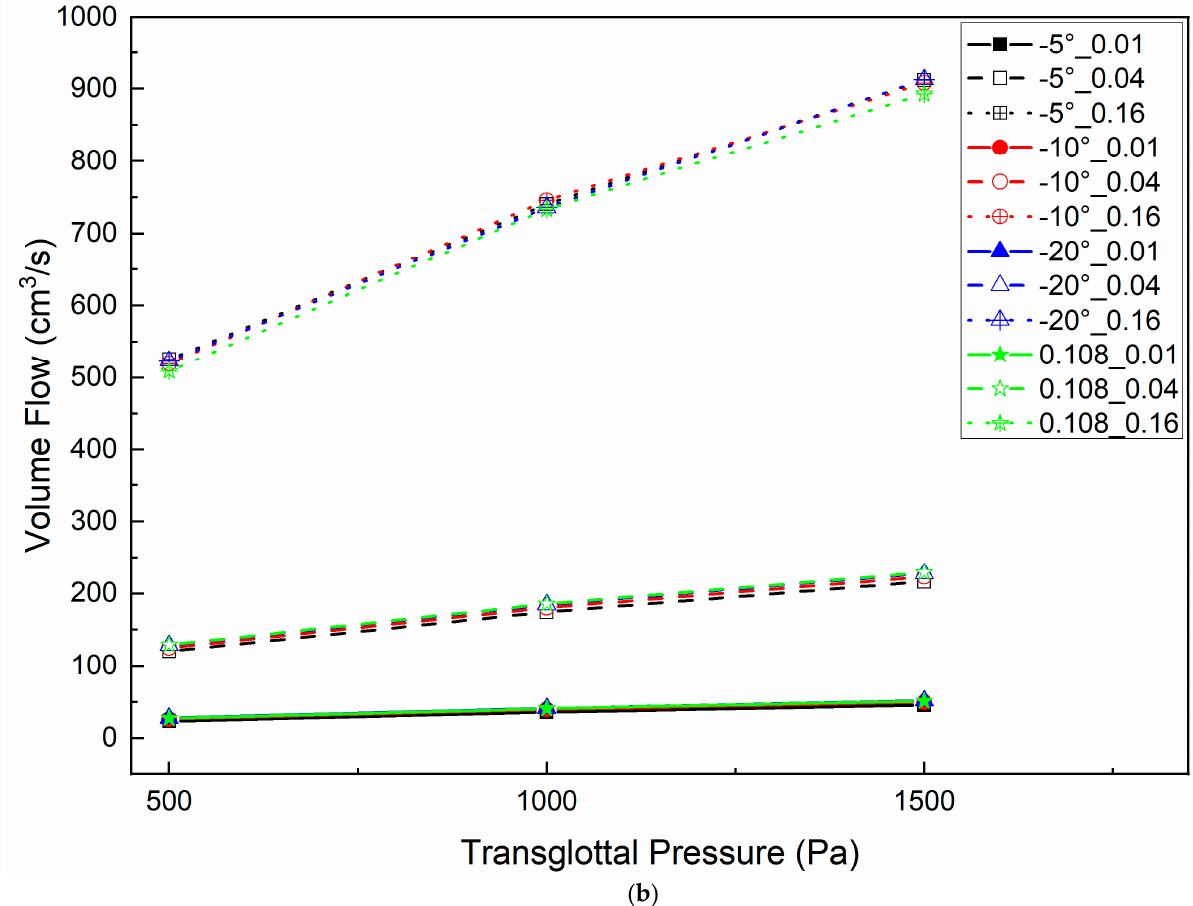
Figure 6. (Color online) Glottal flow distributions for − 5°, − 10°, and − 20° convergent glottal angles and 0.01 cm, 0.04 cm, and 0.16 cm glottal minimal diameters ( a ) for 500 Pa transglottal pressure only; ( b ) for 500 Pa, 1000 Pa, and 1500 Pa transglottal pressures, for 0.108 cm and 0.308 cm vertical glottal duct length.